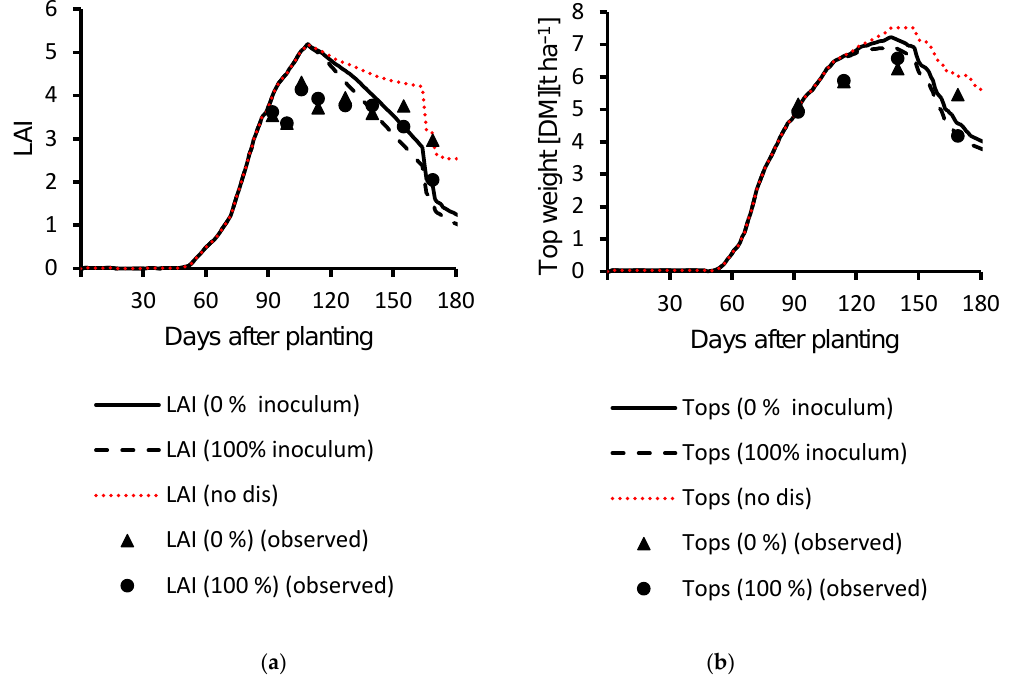
Figure 9. Simulated and observed values (2017): ( a ) LAI; ( b ) top weight (DM t ha − 1 ) for the evaluation treatment with (0% inoculum, 100% inoculum) and without (“no dis”) simulated Cercospora leaf spot disease damage included in the simulation.